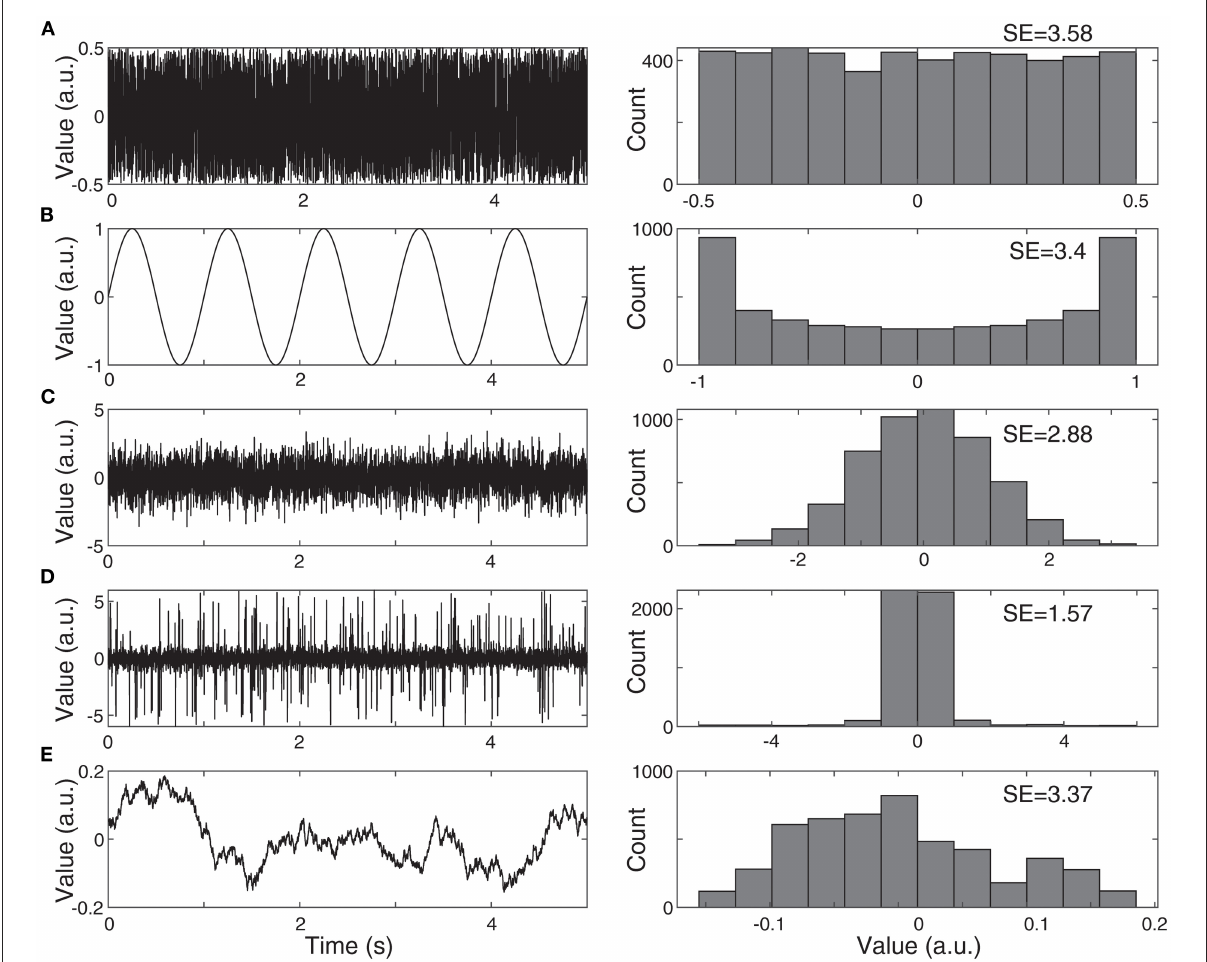
FIGURE2 Examples of Shannon entropy (SE). (A) The SE of white noise is high, as all values occur with equal probability. (B) The SE of a sine wave is almost as high as white noise, despite the drastically different visual appearance. The SE is calculated based only on the signal’s histogram, and both a sine wave and white noise have fairly flat histograms, with almost equal probability for all values. (C) Normally-distributed noise has lower SE, as it is more likely to have values near zero. (D) Normally-distributed noise with outliers has even lower SE, as the probability of having values near zero is increased, relative to the range of possible values. (E) Noise with a 1/f power spectrum, similar to EEG, generally has relatively high values of SE.